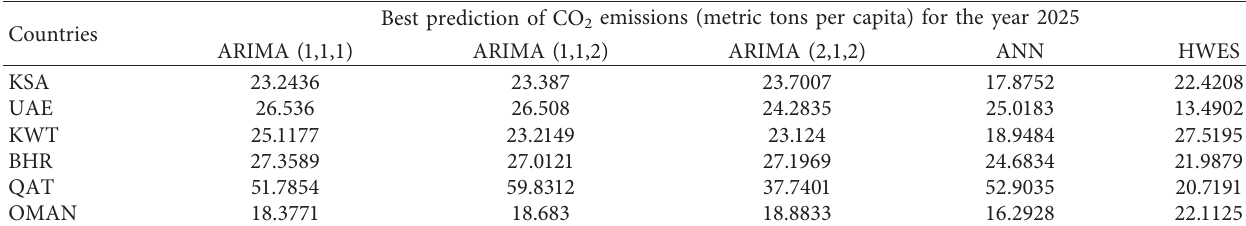
Figure 6: Predicted value of CO 2 emissions (metric tons per capita) using the Holt-Winters exponential smoothing Table 6: Best predicted value of CO 2 emissions for the year 2025.